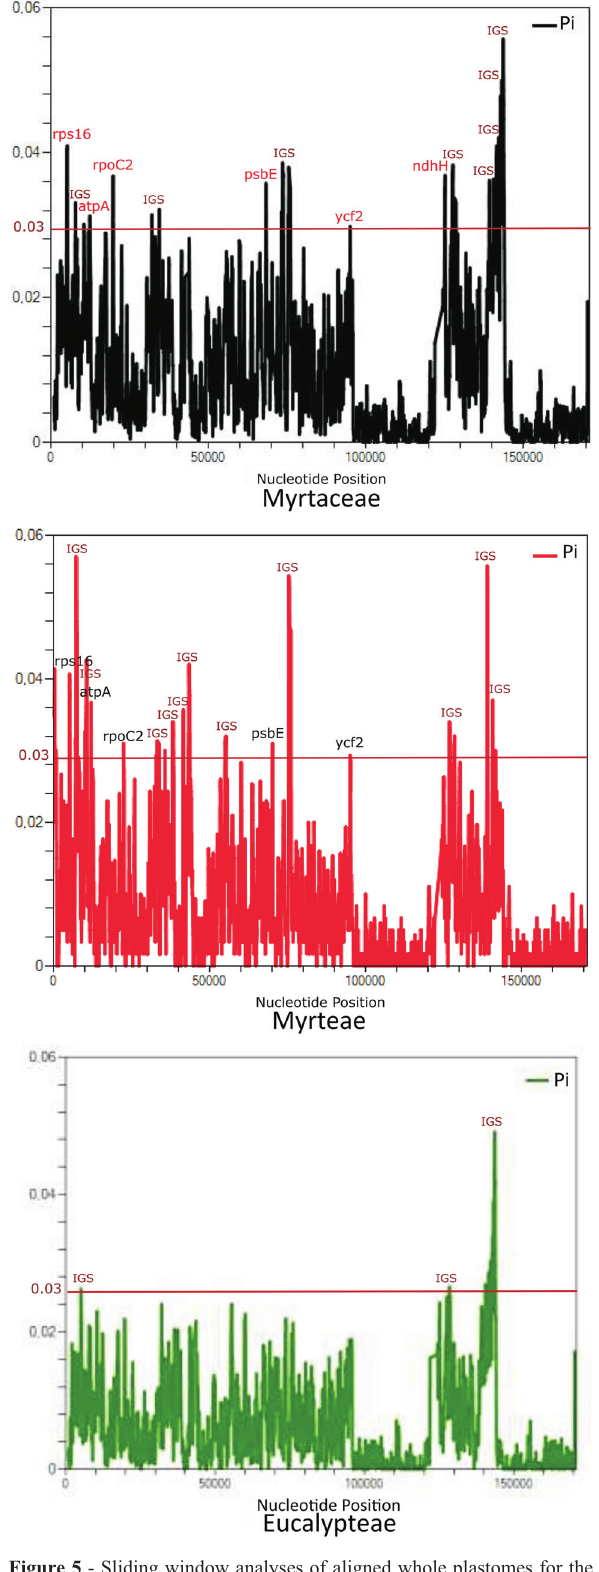
Figure 5 - Sliding window analyses of aligned whole plastomes for the family Myrtaceae, the tribe Myrteae and the tribe Eucalypteae. The re- gions with high nucleotide variability (Pi > 0.03) are indicated. Pi = nucle- otide diversity within each